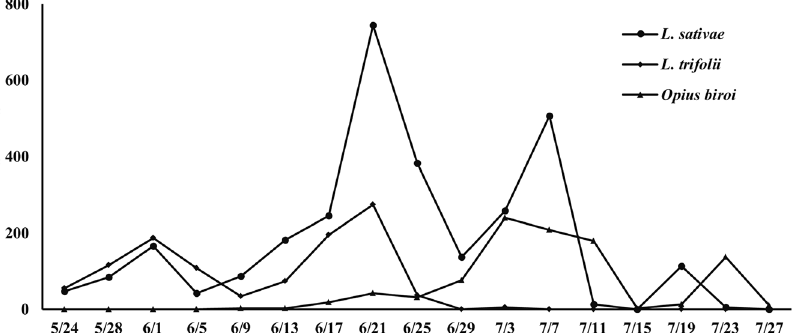
Figure 1. Population dynamics of the two leafminers, Liriomyza sativae and L. trifolii and the pupal parasitoid, Opius biroi